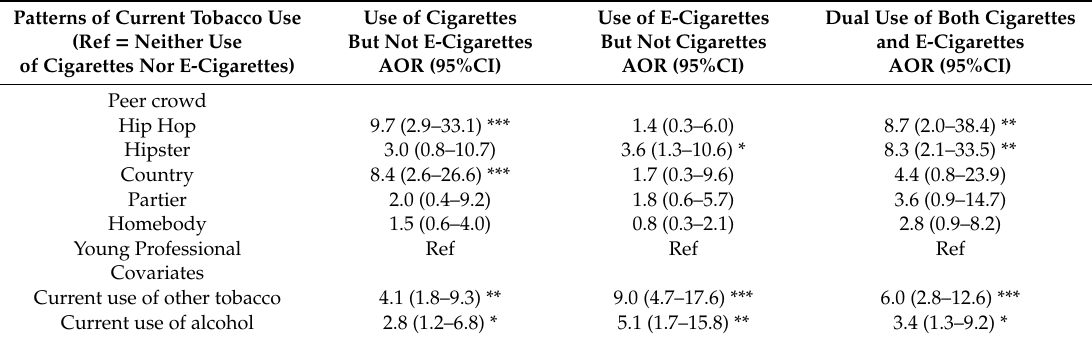
Table 3. Di ff erential associations between peer crowd a ffi liation and patterns of current cigarette and e-cigarette